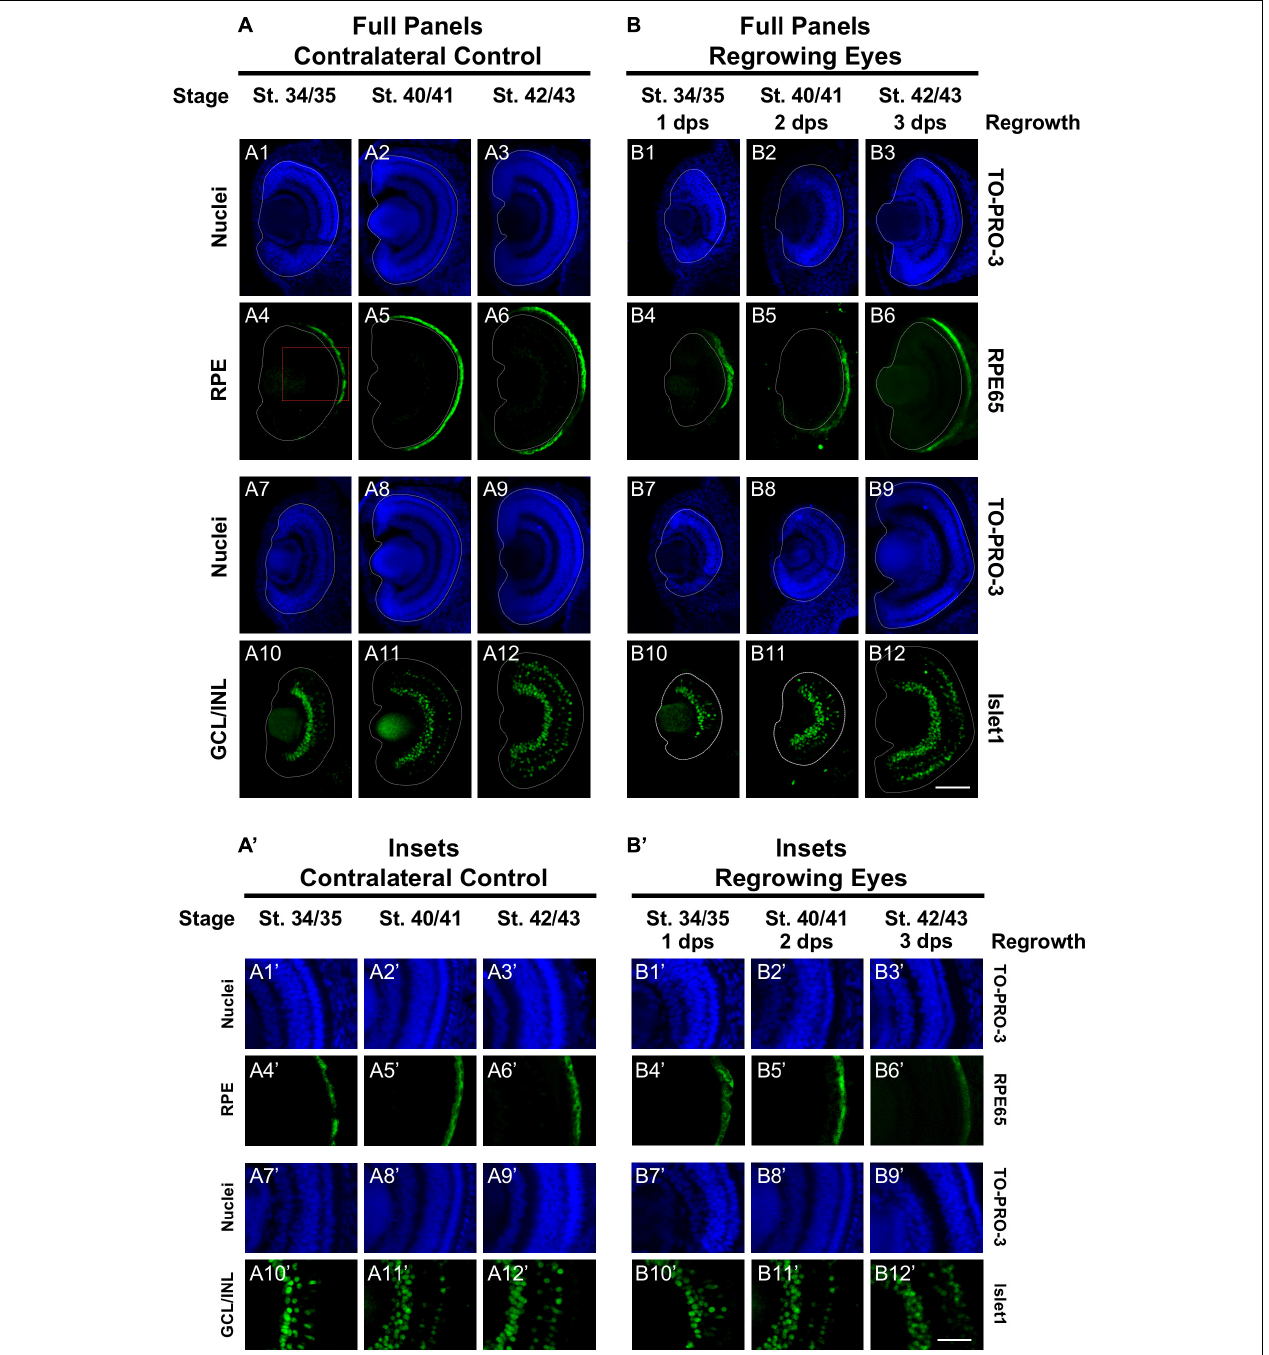
FIGURE 2 | Regrown eyes regain retinal differentiation by 3 dps. Images shown are immunostained, transverse sections at three developmental timepoints corresponding to 1, 2, and 3 days post surgery (dps). (A,B) The contralateral control eyes (unoperated) complete retinogenesis by st. 41. By 1 dps, RPE is already visible in the regrowing eye as shown by anti-RPE65 signal (retinal pigmented epithelium; green). By 3 dps, Islet1 expression (identifying subpopulations of retinal ganglion cells and subsets of amacrine cells, bipolar cells, and horizontal cells; green) show expected retinal patterning of a mature eye. White dashed lines delineate each eye. (A’,B’) Images shown in panels A’ and B’ correspond to the region shown in the inset box in panel A4 for the corresponding (A or B) panel at high magnification. Blue color indicates nuclear staining (TO-PRO-3). Sample sizes: 1 day, n = 5; 2 days, n = 7; and 3 days, n = 6. (A,B, A’,B’) Up = dorsal, down = ventral, lens is on the left. Scale bar: (A,B) = 100 µ m and (A’,B’) = 50 µ m.